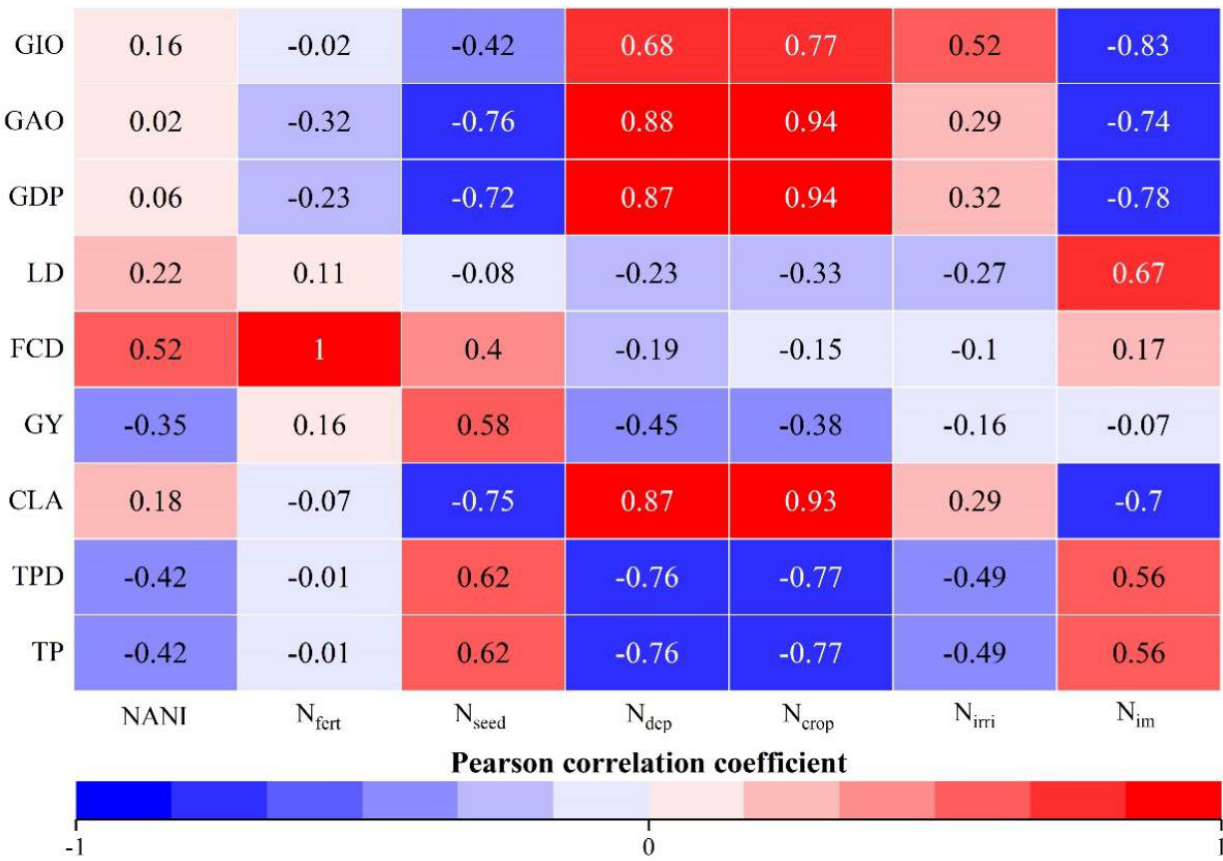
Figure 6. Pearson correlation coefficients between NANI and its components and economic, agricul- tural, and social factors.